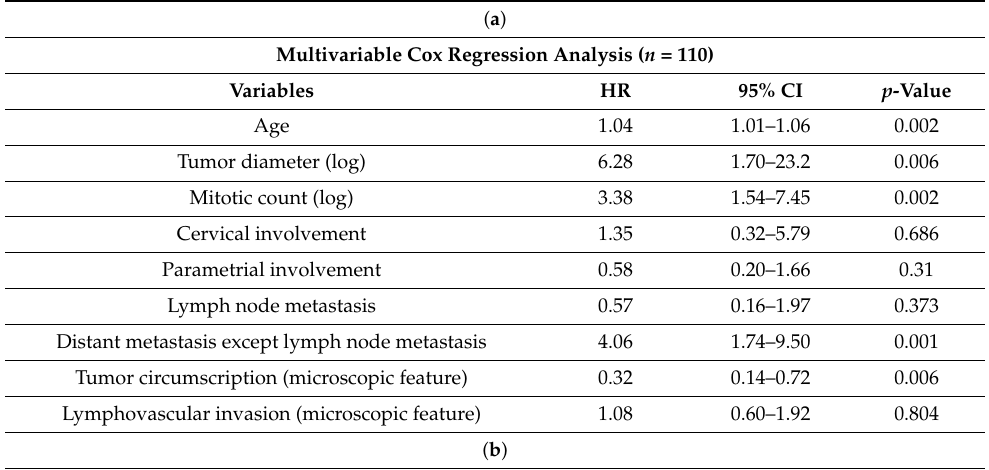
Figure 1. Overall survival of 201 uterine leimyosarcoma patients and 110 patients with complete data. Table 3. ( a ) Multivariate Cox regression analysis ( n = 110). ( b ) Multivariate binomial regression analysis for constructing prediction model ( n =